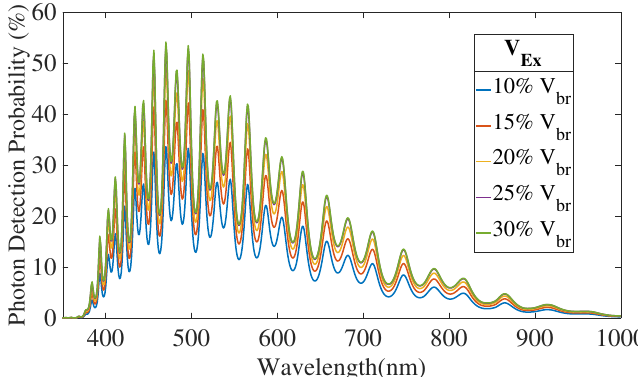
Figure 11. Photon Detection Probability simulation results, without substrate contribution.